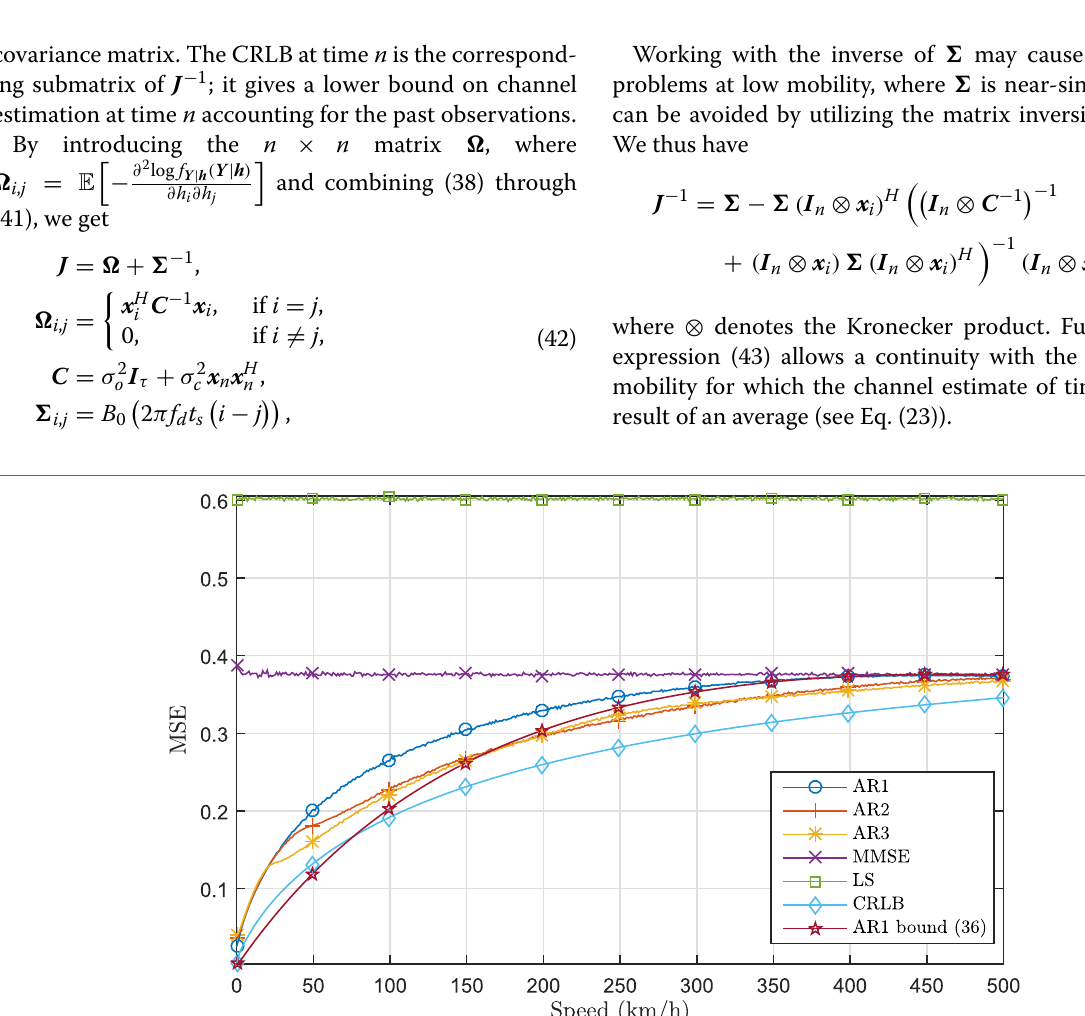
Fig. 8 Comparison between the proposed scheme and conventional solutions with respect to mean squared error as a function of mobility. The M1 mobility model is applied, and SIR is 2.2